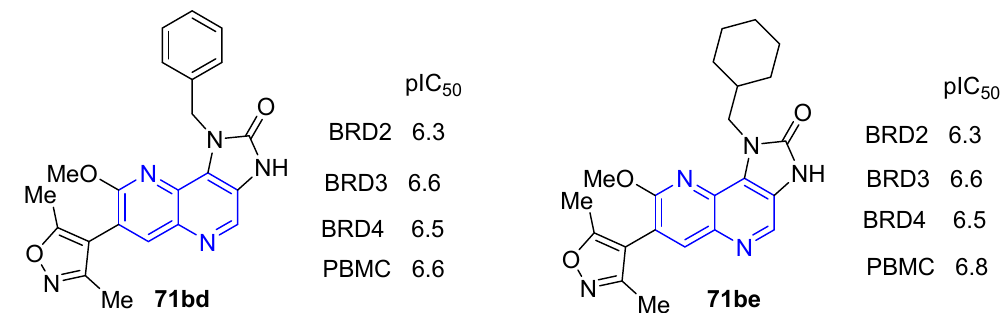
Figure 7. Inhibitory activity of compounds 71bd and 71be on BET bromodomain family.